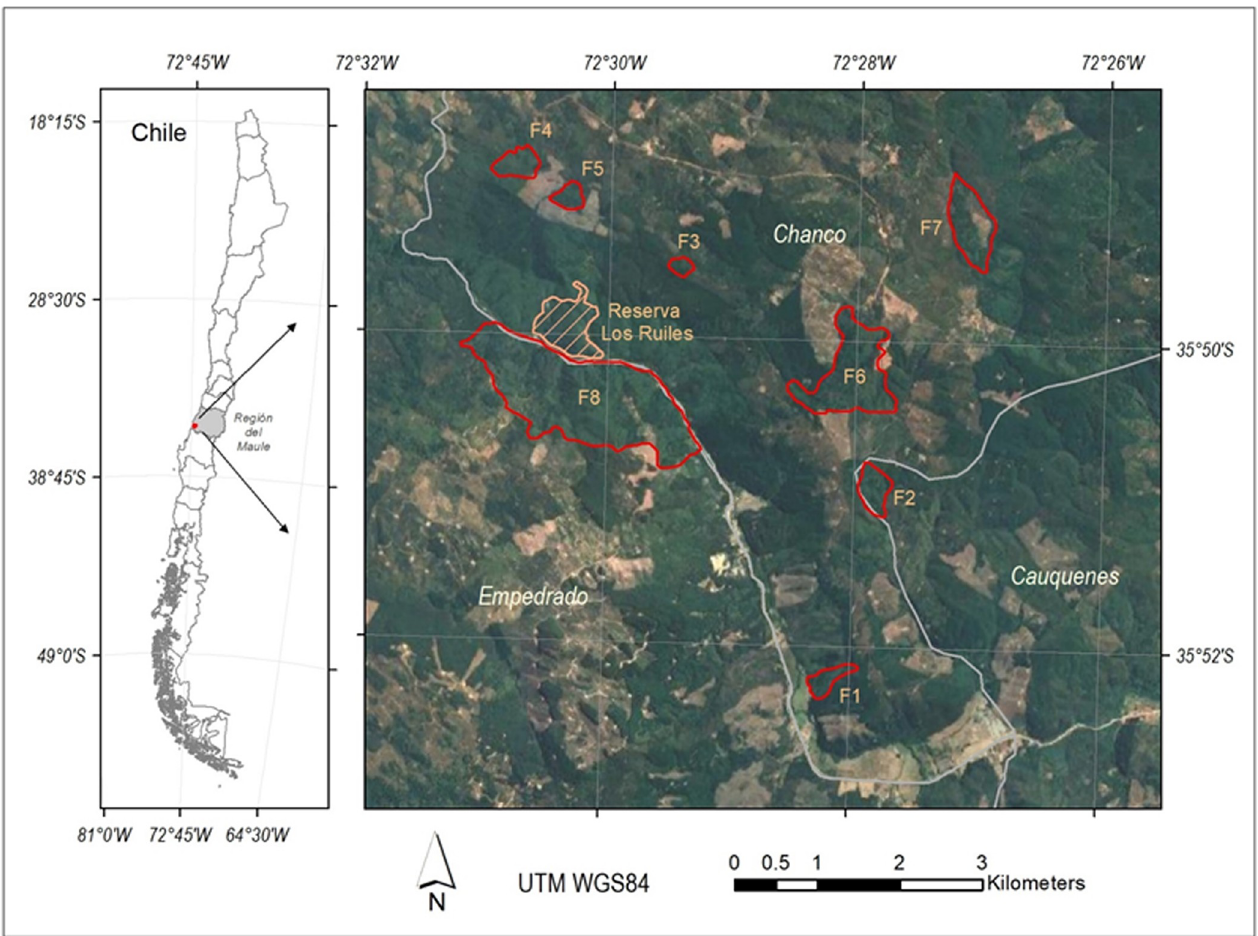
Fig 1. Spatial distribution of Coastal Maulino forest fragments, Cauquenes, Maule Region, Chile. Red contours show eight fragments of native forest; the remaining colors indicate pine plantations in different development phases. In achurate: National Reserve Los Ruiles.